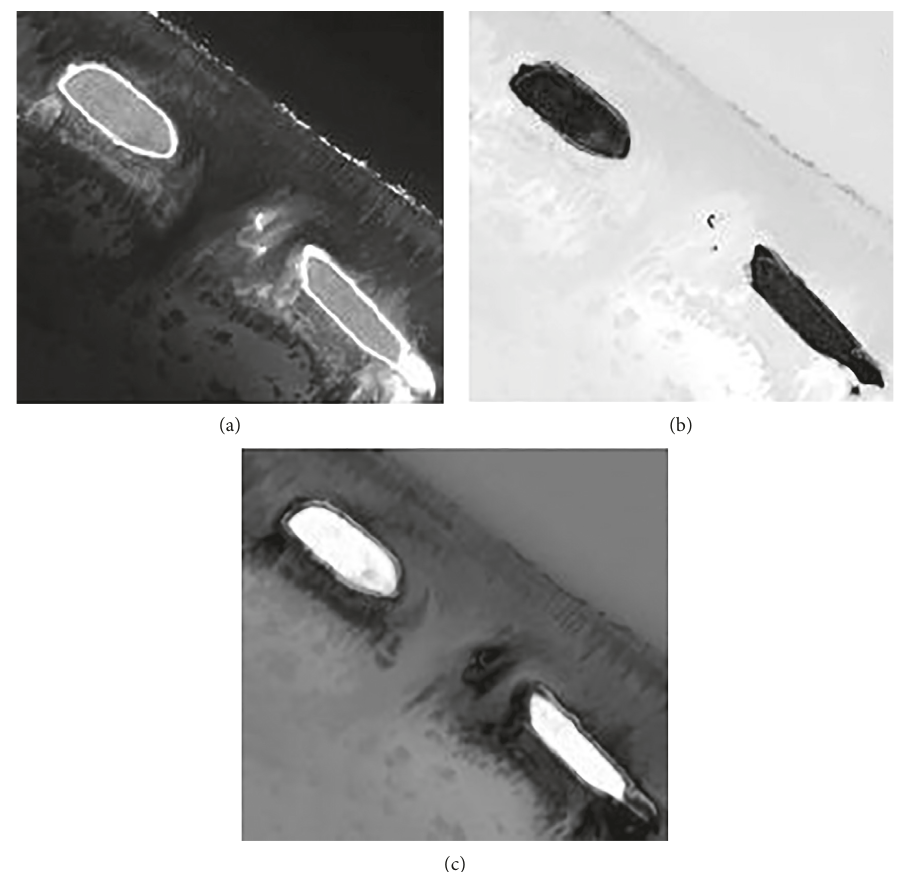
Figure 3: Image after PCA transformation and compression: (a) first principal component, (b) second principal component, and (c) third principal